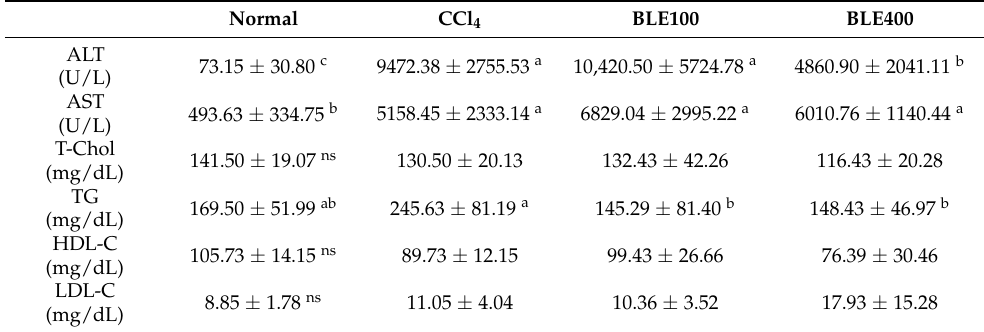
Table 2. Effects of BLE on serum levels of ALT, AST, and lipids in CCl 4 -treated BALB/c